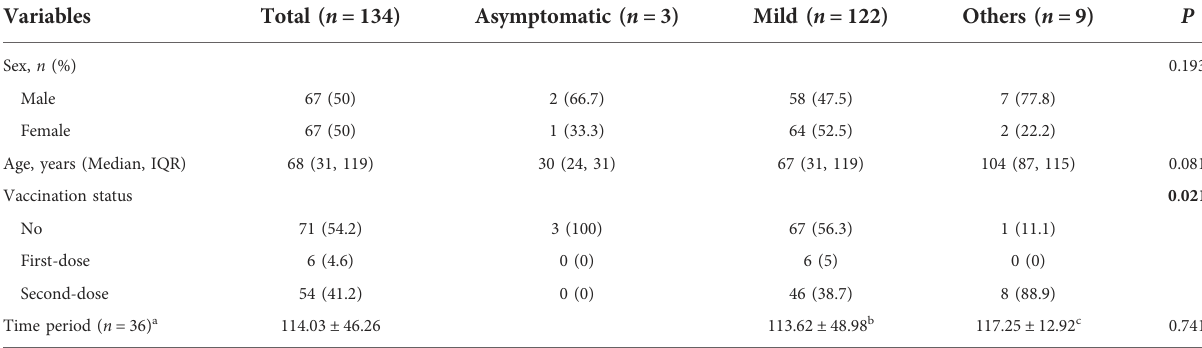
TABLE 5 Vaccination status among children with different types of COVID-19.